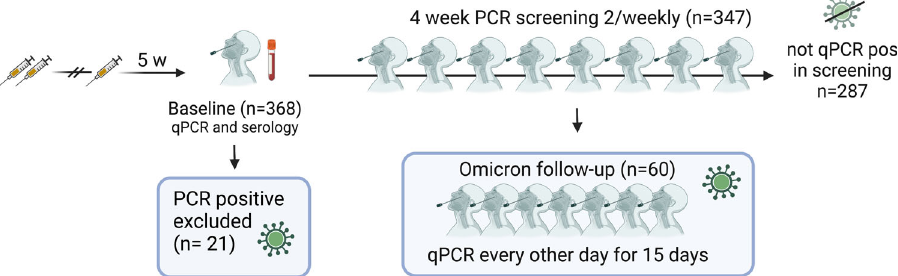
Fig. 1 | Overview of study cohort. Nasal/oropharyngeal/saliva swabs for PCR, mucosal antibody analysis 12 and serum were collected at enrolment (baseline). Participantswho testedqPCRpositive atenrolment( n =21)wereexcluded fromall analyses except for estimation of cumulative incidence. Self-administered nasal/ oropharyngeal/saliva swabs for qPCR were collected twice weekly for 4 weeks